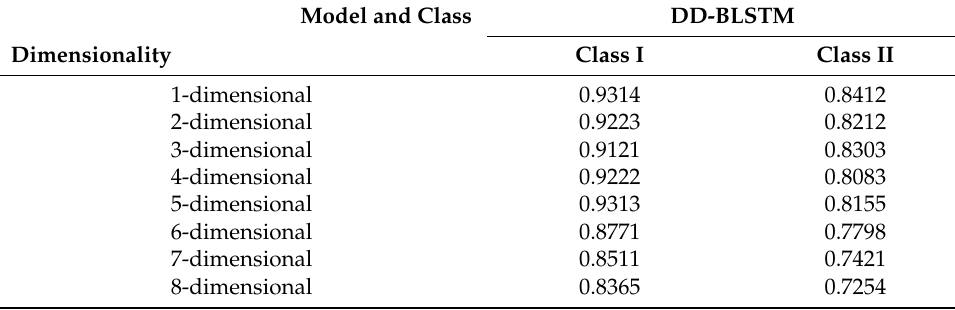
Table 5. Comparison of the prediction accuracy with different dimensionality reduction.